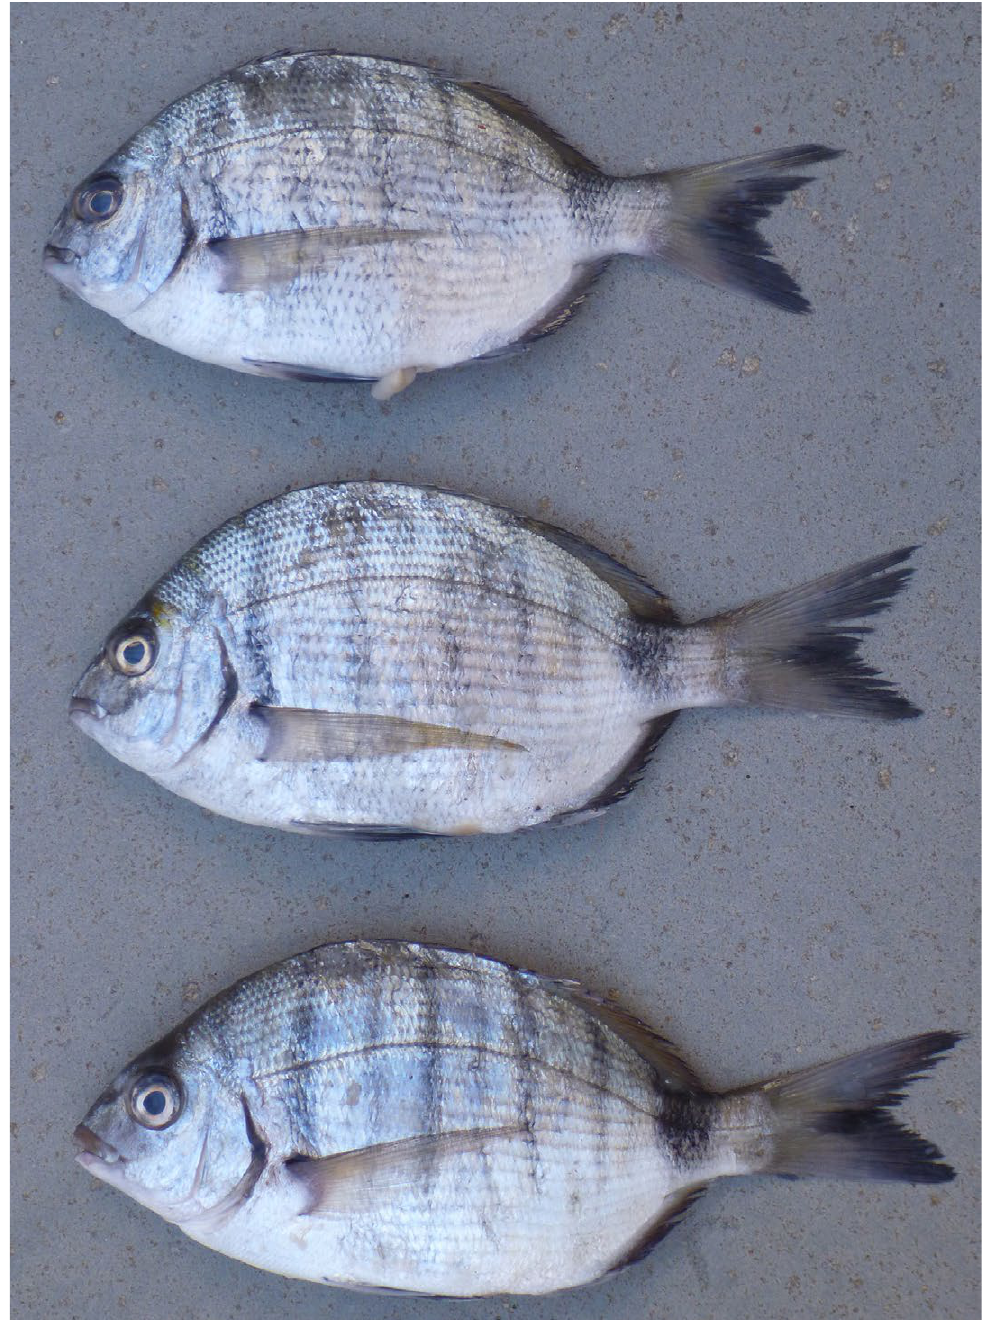
Fig. 9. – Diplodus cadenati , HUJ 20532, 3 spec (upper to lower: 151, 149, 140 mm SL), Tenerife, Canary Islands, 25 July 2015. Lateral view; photograph of the fresh colouration taken a few hours after collection (Photograph: R.